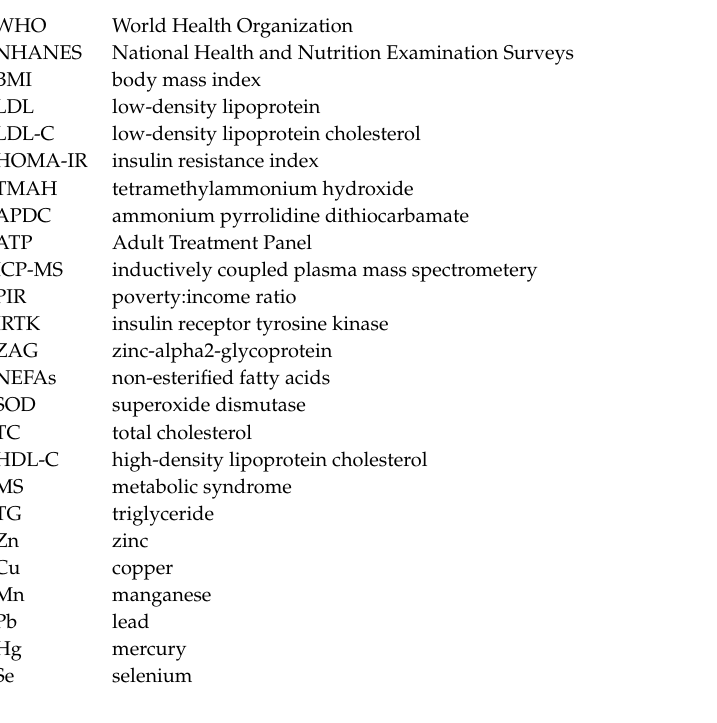
Table S1. Distribution of serum metal concentrations in children and adolescents in National Health and Nutrition Examination Surveys (NHANES) 2011–2014, Table S2. Spearman correlation between different serum